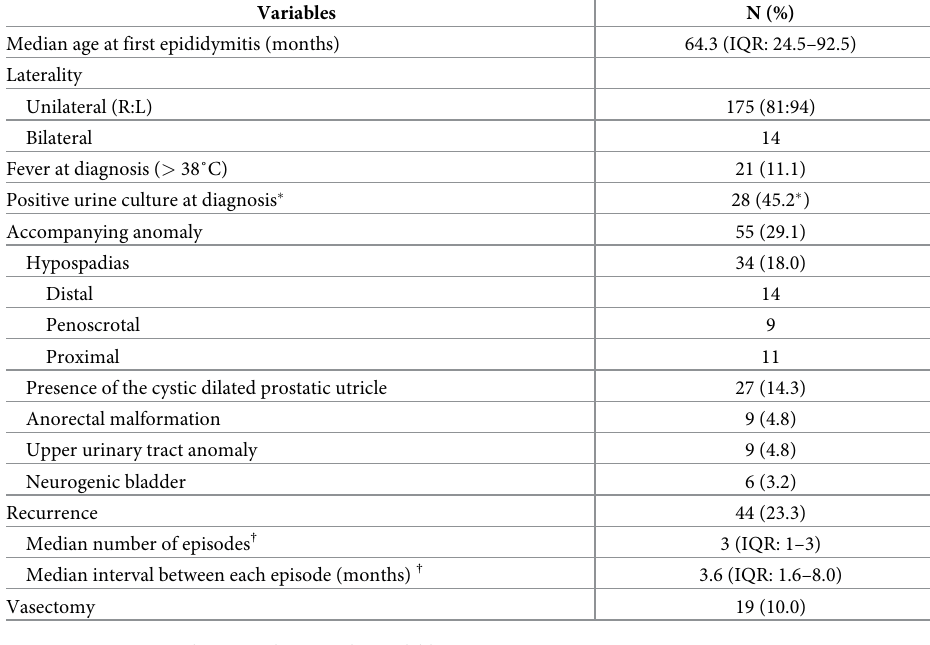
Table 1. Patient characteristics (N = 189).